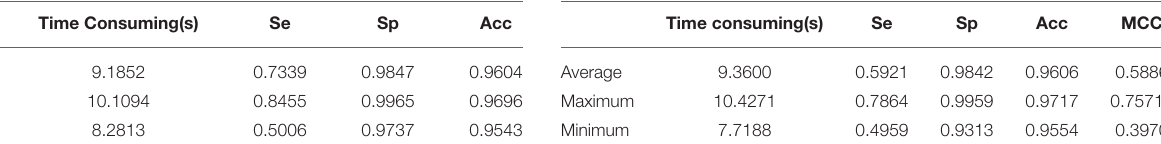
TABLE 5 | Performance of proposed method